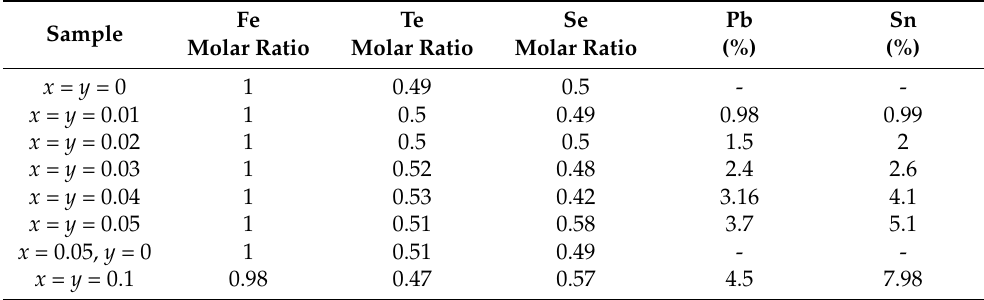
Table 2. List of molar ratios of various elements presented in FeSe 0.5 Te 0.5 + x Pb + y Sn